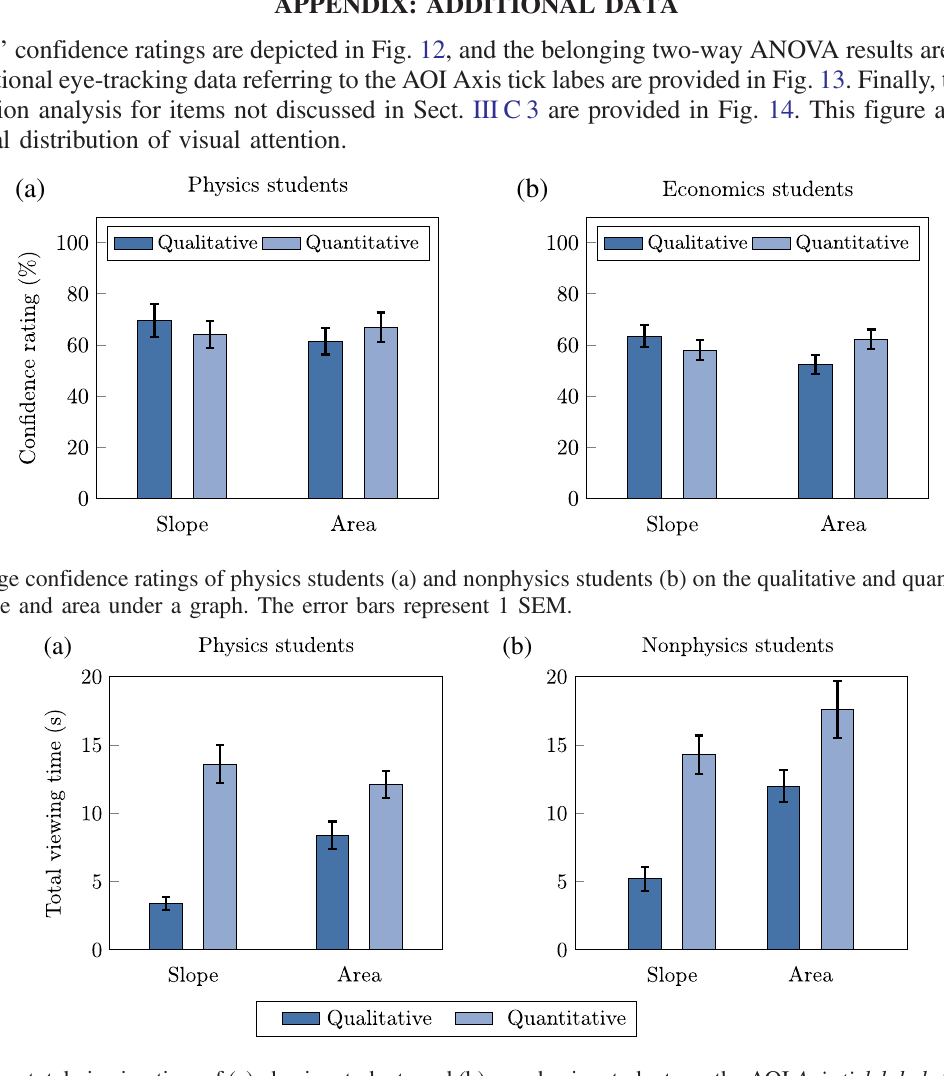
FIG. 13. Average total viewing time of (a) physics students and (b) nonphysics students on the AOI Axis tick labels for qualitative and quantitative questions about graph slope and area under a graph. The error bars represent 1